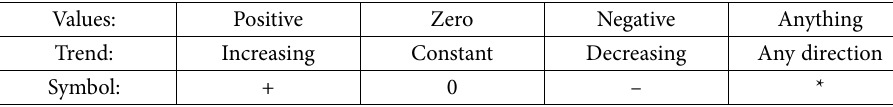
Table 2. The quantifiers (source: Vicha & Dohnal, 2008) Values: Positive Zero Negative Anything Trend: Increasing Constant Decreasing Any direction